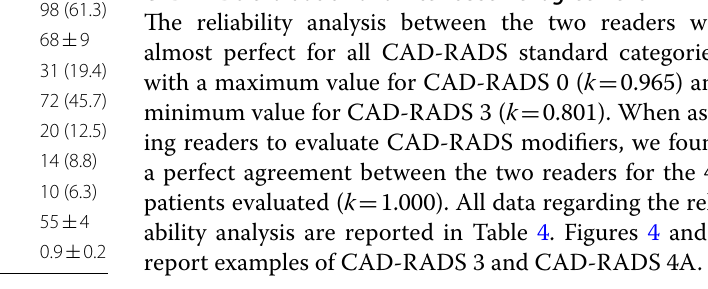
CAD coronary artery disease, SD standard deviation Table 3 Comparison between MBIR and IR for HU, SD (noise), CNR and SNR. Comparisons were computed using t-Student’s test